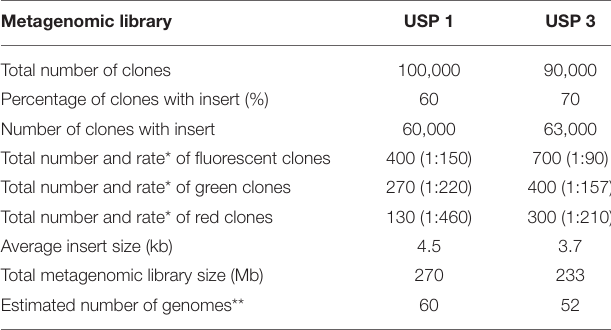
TABLE 1 | Features of the generated metagenomic